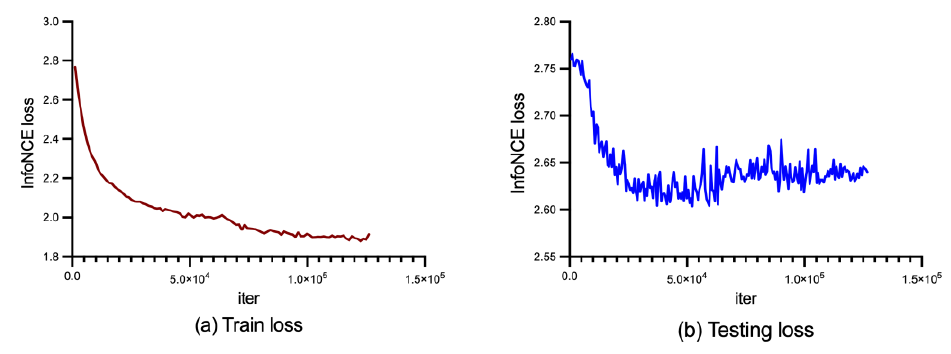
Figure 12. Train and test loss using InfoNCE loss, group 2: ( a ) the train loss; ( b ) the test loss; the model is overfitting after nearly 4 × 10 4 batch iterations. The lowest values of the test loss are nearly 2.60 at the 37,261 batch iterations. This is a representative convergence result in the training process, during nearly 200 epochs which took 2 days using three